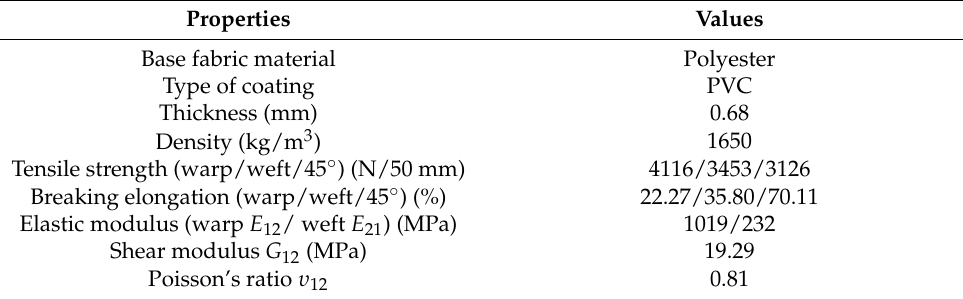
Table 2. Main material parameters of fabric